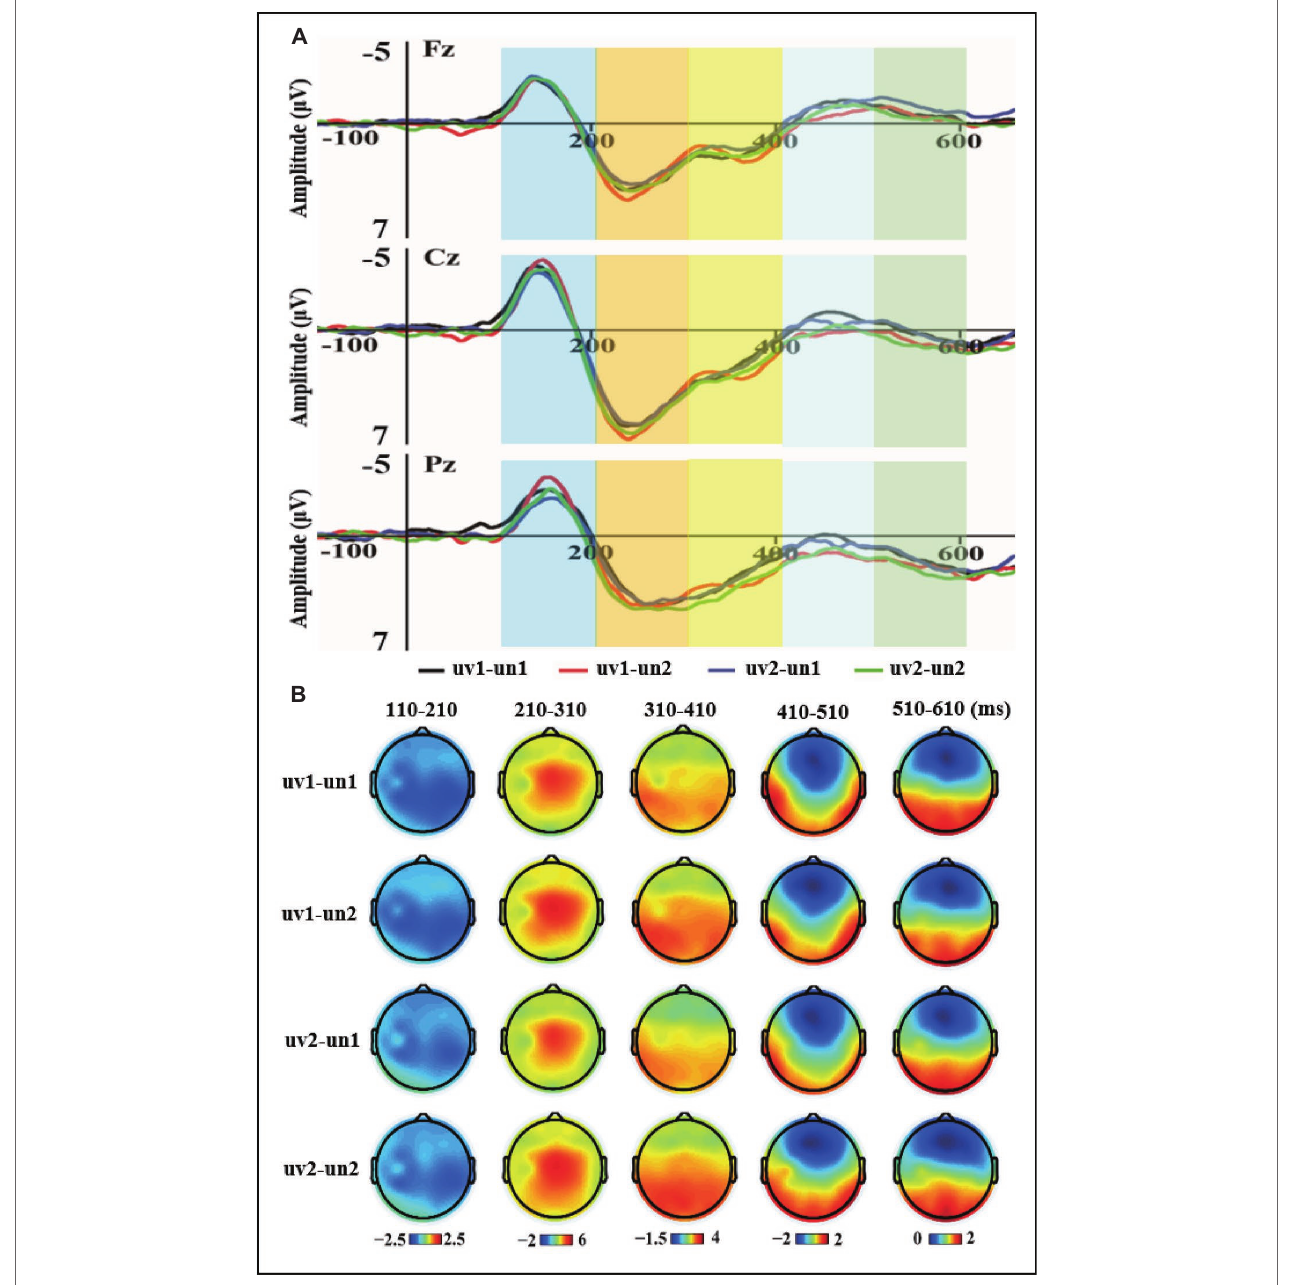
FIGURE 3 | The grand-averaged ERP waveforms at Fz, Cz, and Pz and the scalp voltage topographic maps of five time-windows for four conditions. (A) The grand-averaged ERP waveforms with different color bars for five time-windows were shown in the upper panel. (B) The scalp voltage topographic maps of five time-windows for four conditions were shown in the bottom